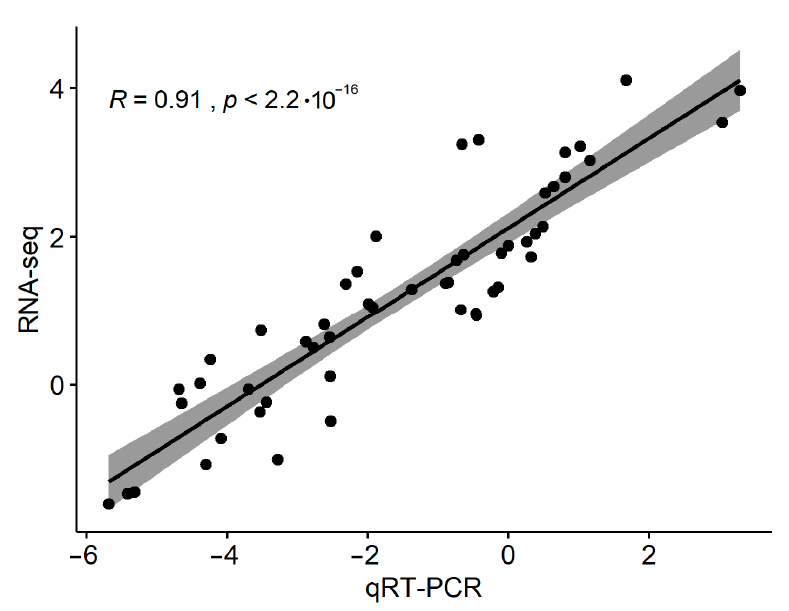
Figure 6. Transcript abundance estimated from qPCR analysis and from RNA-Seq data. The y axis represents log 10 (TPM), and the x axis represents log 10 (2 − ∆ Ct ). The shadow band shows the confidence